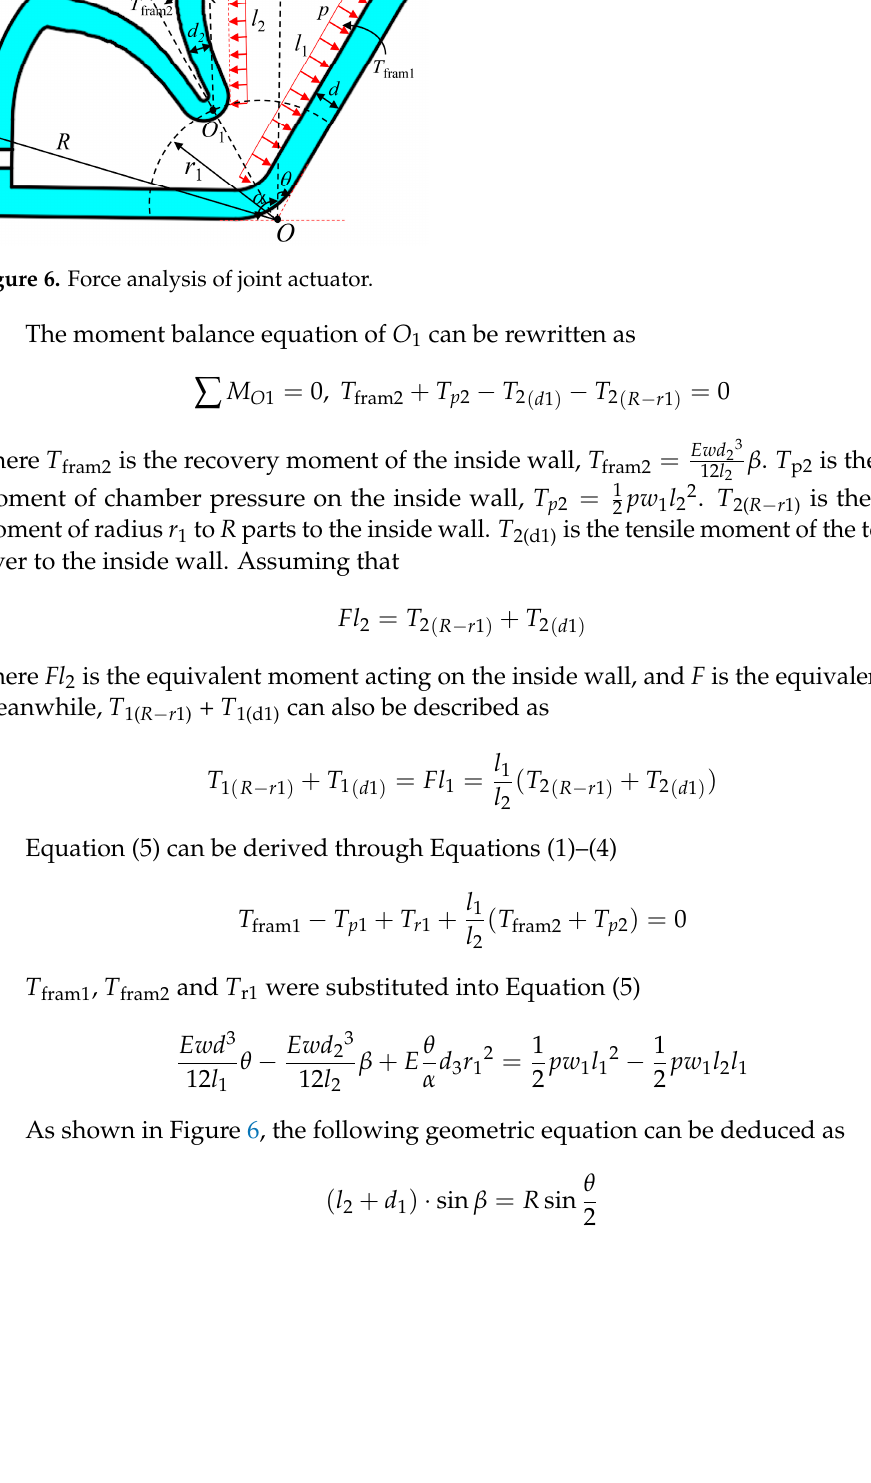
Figure 5. Assembling of the soft arthropod robot. (Including three exoskeletons produced by the stereolithography 3D printer, two springs, a soft barb, and two flexible joints made of silica gel).